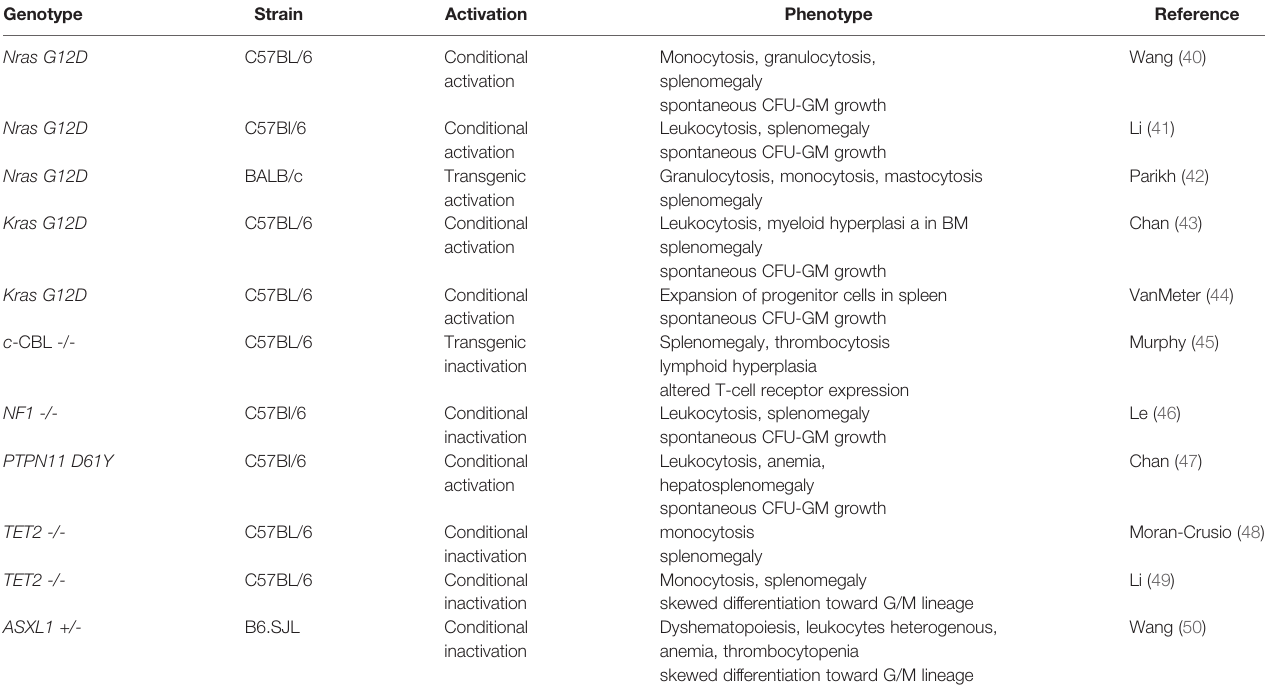
TABLE 3 | Mouse models with CMML-like